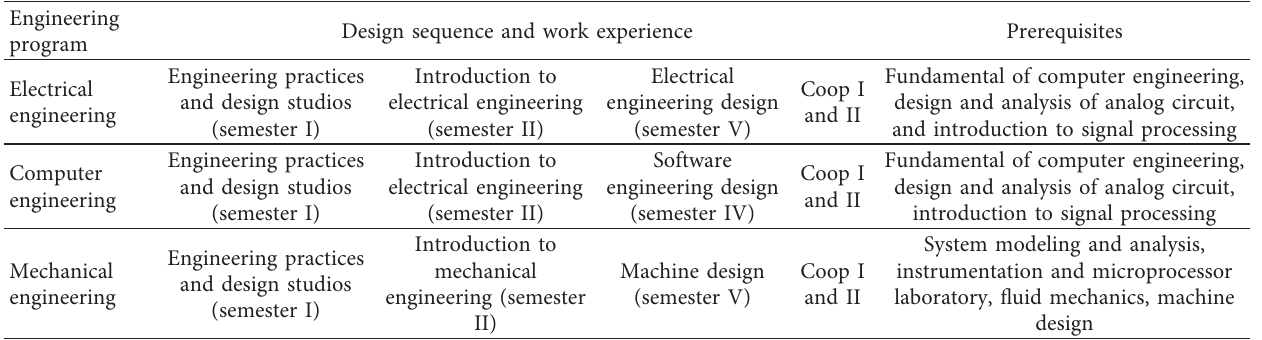
Table 1: Design course sequence, coop, and prerequisites for the capstone